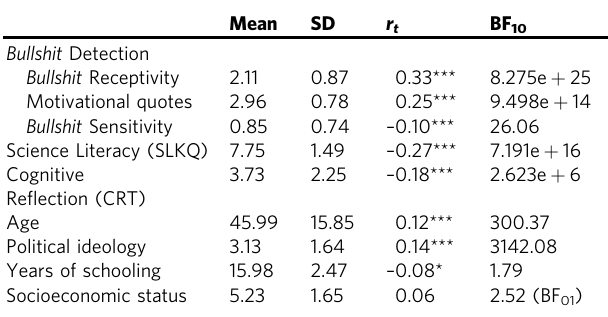
Table 2 Mean and SD of the participants ’ scores on the cognitive questionnaires and sociodemographic characteristics, as well as their Kendall ’ s τ correlations with scores on the sPES.